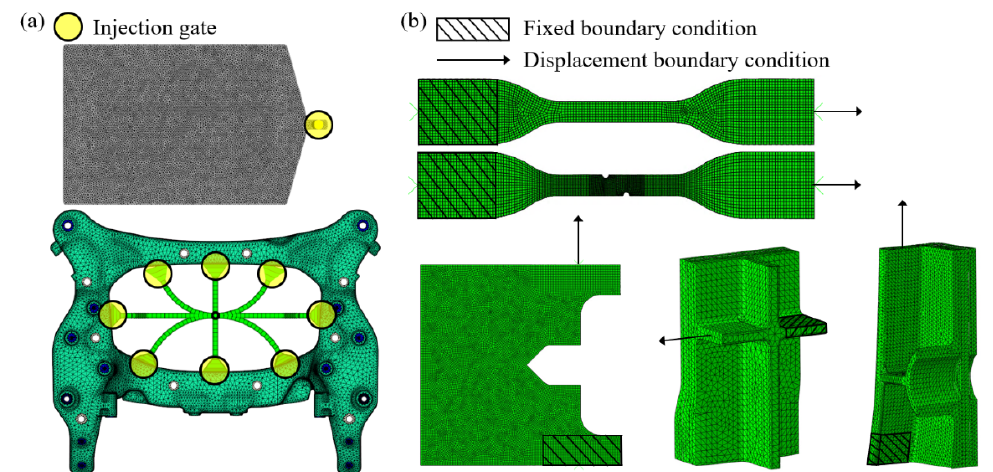
Figure 6. Boundary conditions and simulation models. ( a ) The injection gate and tetrahedra mesh for the injection molding simulation. ( b ) Mechanical boundary conditions for structural analysis.